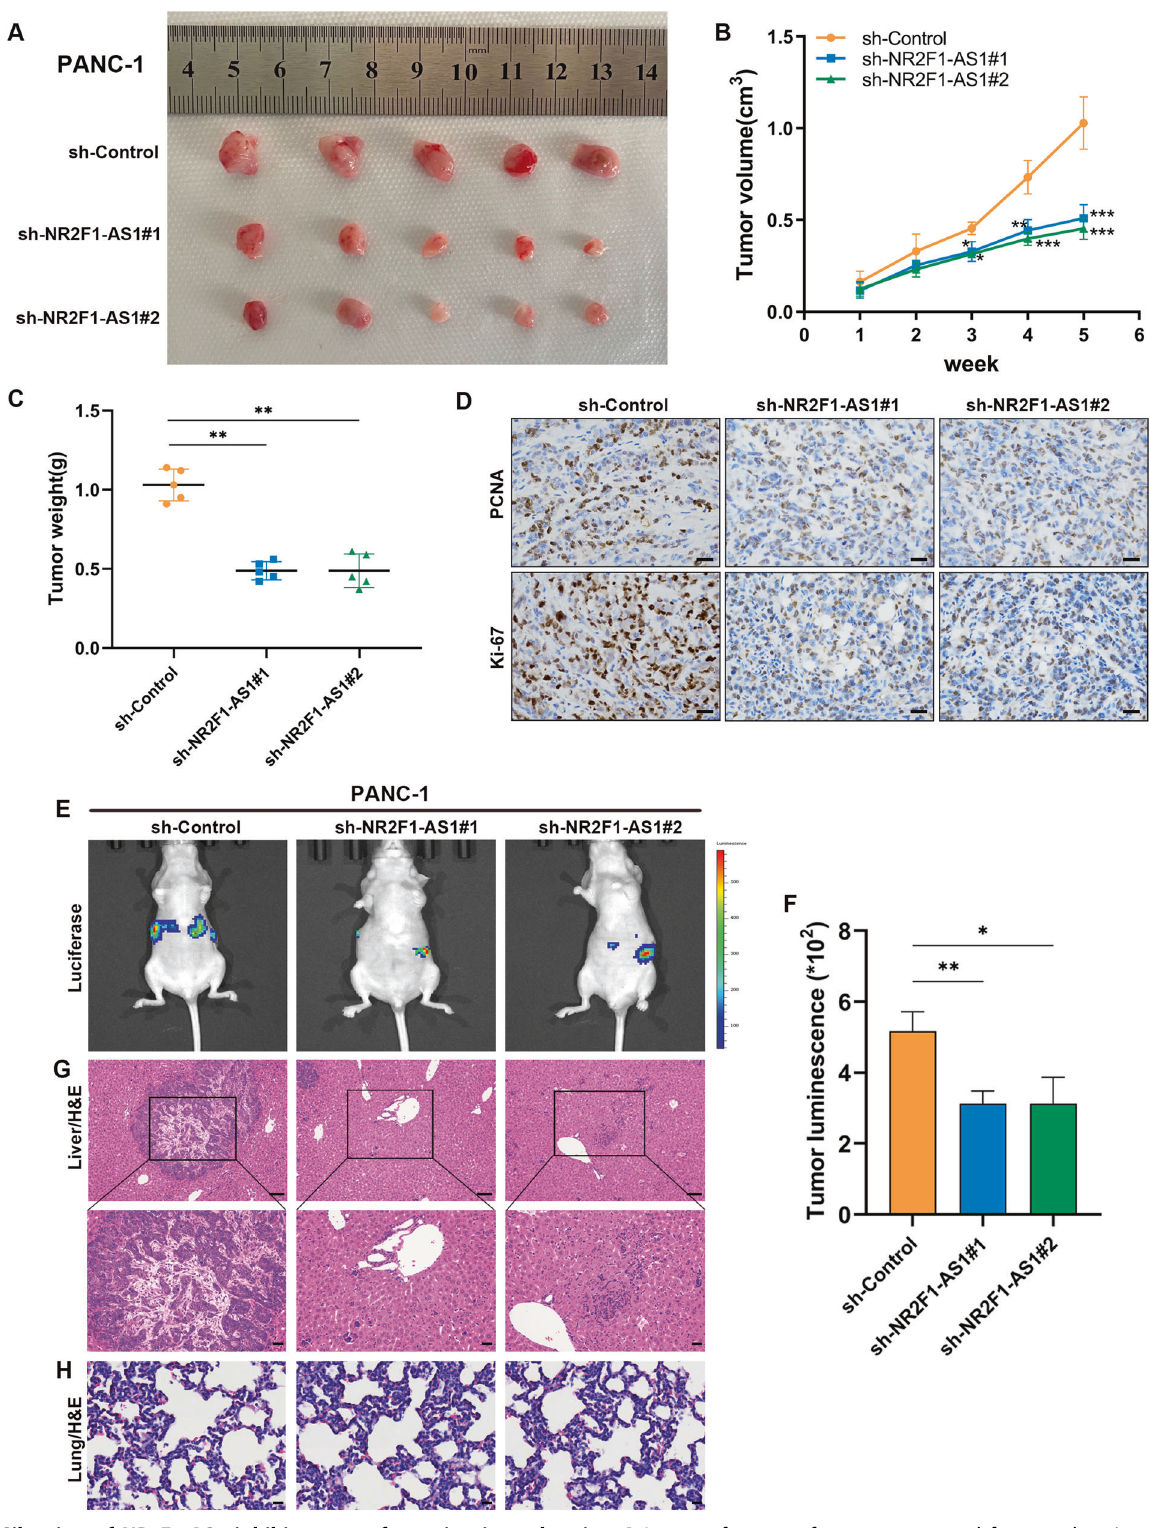
Fig. 3 Silencing of NR2F1-AS1 inhibits tumor formation in nude mice. A Image of xenograft tumors resected from nude mice-carrying PANC-1 cells that transduced with lentiviruses encoding sh-Control, sh-NR2F1-AS1#1, or sh-NR2F1-AS1#2 ( n = 5). B Growth curves of the subcutaneous tumor were made from weekly measurements of tumor volume. C Weights of the subcutaneous tumors in each group were measured after 5 weeks when the mice were sacri fi ced. D Representative images of IHC staining for Ki-67 and PCNA in the tumor sections from sh-Control, sh-NR2F1-AS1#1, or sh-NR2F1-AS1#2 xenografts; scale bar = 100 μ m. E – H Representative fl uorescent images of microscopic metastatic nodules after 5 weeks ( n = 5), and liver ( G ) and lung ( H ) tissues stained with hematoxylin and eosin (H&E); scale bar = 20 μ m. Data are expressed as mean ± SD. * P < 0.05, ** P < 0.01, *** P < 0.001.